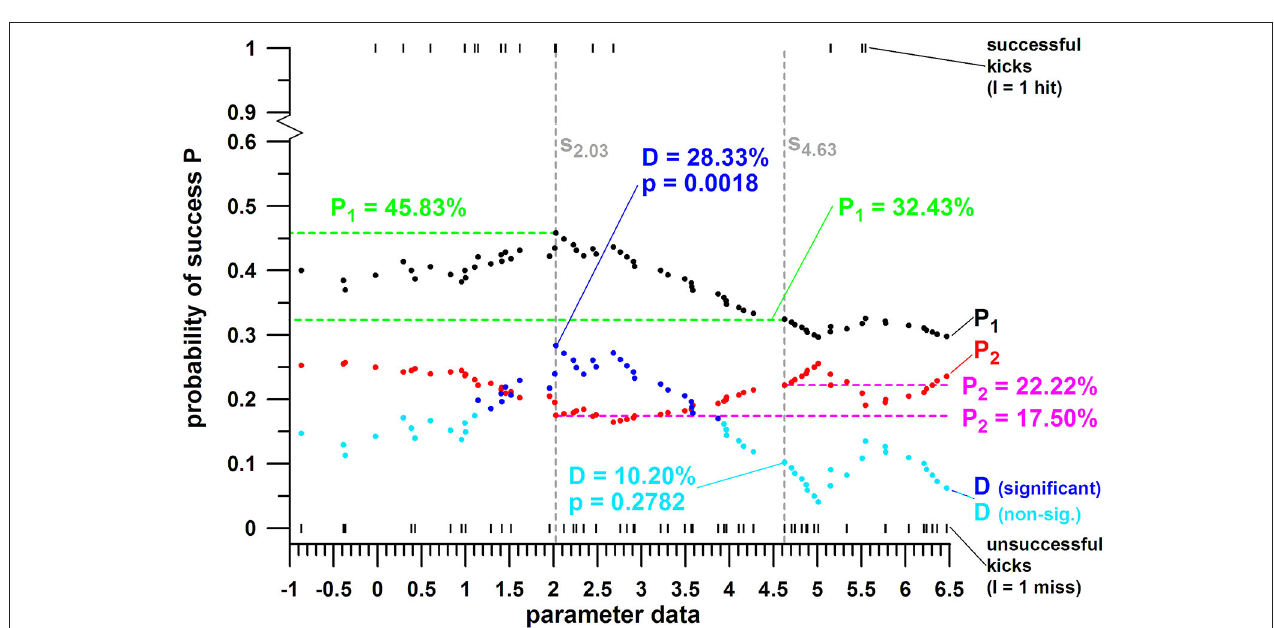
FIGURE 5 | Example of probability of success (P) against the range of parameter data with two threshold value s ( s = 2.03 and s = 4.63); P 1 = average of hit and miss data for the parameter range smaller than the threshold value s (s = 6.5); P 2 = average of hit and miss data for the parameter range larger than the threshold value s ; D = probability differential (P 1 – P 2 ; D is greater for s = 2.03); P 1 and P 2 are significantly different ( p = p -value) for s = 2.03 and insignificantly different for s = 4.63.